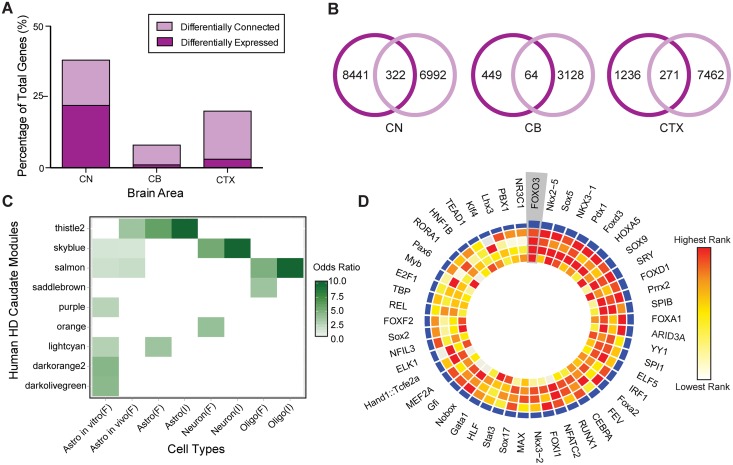
Network-specific pathology and functional characterization of CN Thistle2 module.(A,B) Differential connectivity analysis reveals network-level alterations (light purple) that were not observed by previous differential expression analysis in the same cohort1 (dark purple). (B) Venn diagrams depict the number of genes identified by differential connectivity (light purple) and differential expression analyses (dark purple), as well as their overlap. (C) CN modules showing enrichment for previously published cell-type specific gene signatures identified by FACS (F) and in situ hybridization (I) experiments. Fisher’s exact test odds ratios are plotted only for modules with P < 0.05, two-sided, Bonferroni corrected. (D) Circos plot depicting FOXO3 as the top TF associated with Thistle2 in CN; rings are numbered 1 (outermost) to 5 (innermost). TF binding site enrichment scores are depicted in rings 2, 3, and 4 (Z score, Fisher’s score, and Composite Rank, respectively). Ring 5 depicts the differential expression profile of each TF in HD (-log10(P)). Blue histogram height (ring 1) reflects the cumulative scores of each TF based upon rings 2–5, with taller heights depicts greater relevance to Thistle2.